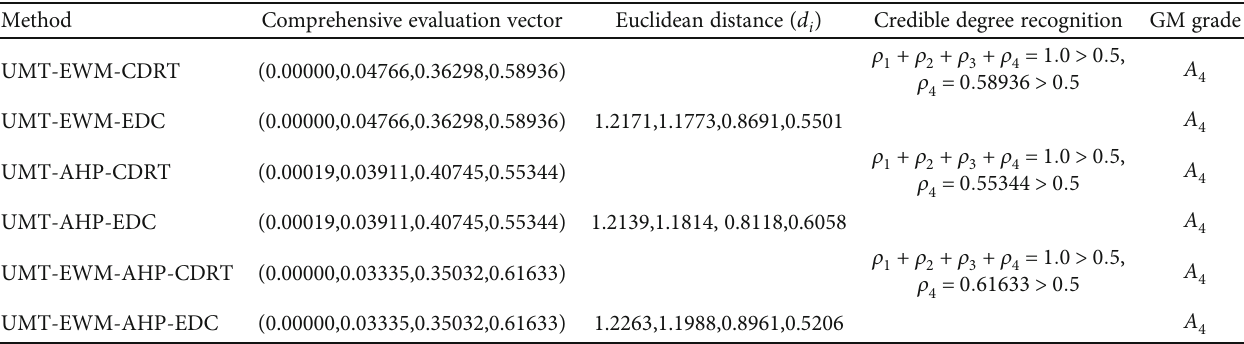
Table 10: Comprehensive evaluation vectors, Euclidean distances, credible degree recognitions, and GM grades for Yirui limestone mine. Method